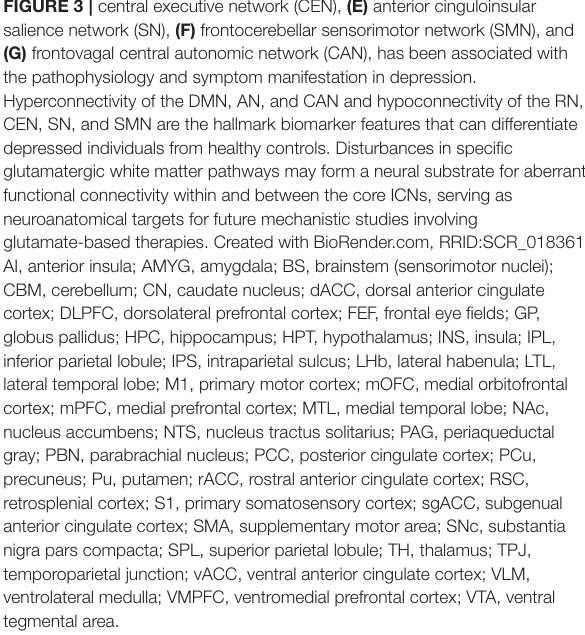
FIGURE 3 | central executive network (CEN), (E) anterior cinguloinsular salience network (SN), (F) frontocerebellar sensorimotor network (SMN), and (G) frontovagal central autonomic network (CAN), has been associated with the pathophysiology and symptom manifestation in depression. Hyperconnectivity of the DMN, AN, and CAN and hypoconnectivity of the RN, CEN, SN, and SMN are the hallmark biomarker features that can differentiate depressed individuals from healthy controls. Disturbances in specific glutamatergic white matter pathways may form a neural substrate for aberrant functional connectivity within and between the core ICNs, serving as neuroanatomical targets for future mechanistic studies involving glutamate-based therapies. Created with BioRender.com, RRID:SCR_018361. AI, anterior insula; AMYG, amygdala; BS, brainstem (sensorimotor nuclei); CBM, cerebellum; CN, caudate nucleus; dACC, dorsal anterior cingulate cortex; DLPFC, dorsolateral prefrontal cortex; FEF, frontal eye fields; GP, globus pallidus; HPC, hippocampus; HPT, hypothalamus; INS, insula; IPL, inferior parietal lobule; IPS, intraparietal sulcus; LHb, lateral habenula; LTL, lateral temporal lobe; M1, primary motor cortex; mOFC, medial orbitofrontal cortex; mPFC, medial prefrontal cortex; MTL, medial temporal lobe; NAc, nucleus accumbens; NTS, nucleus tractus solitarius; PAG, periaqueductal gray; PBN, parabrachial nucleus; PCC, posterior cingulate cortex; PCu, precuneus; Pu, putamen; rACC, rostral anterior cingulate cortex; RSC, retrosplenial cortex; S1, primary somatosensory cortex; sgACC, subgenual anterior cingulate cortex; SMA, supplementary motor area; SNc, substantia nigra pars compacta; SPL, superior parietal lobule; TH, thalamus; TPJ, temporoparietal junction; vACC, ventral anterior cingulate cortex; VLM, ventrolateral medulla; VMPFC, ventromedial prefrontal cortex; VTA, ventral tegmental